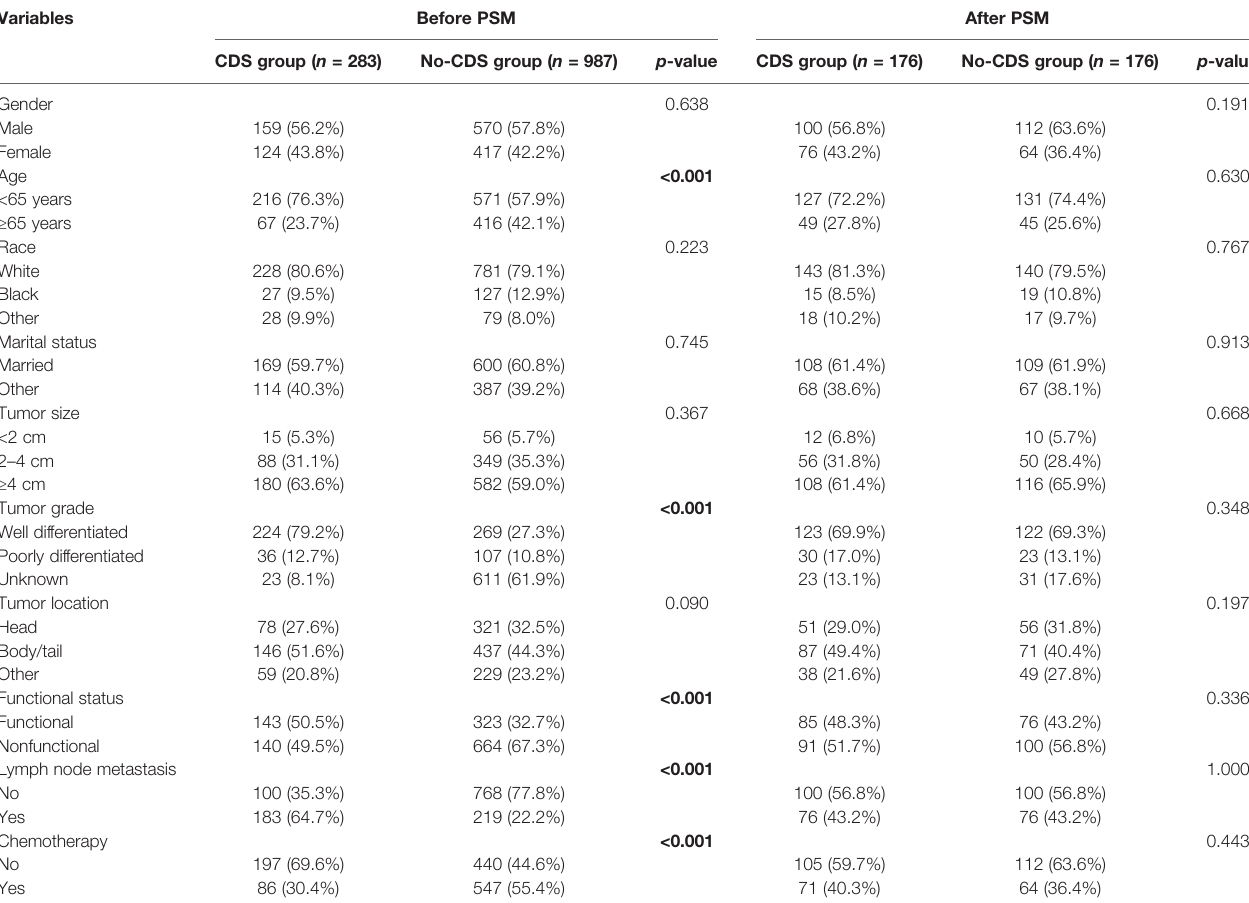
TABLE 1 | Comparison of baseline characteristics before and after propensity score matching.